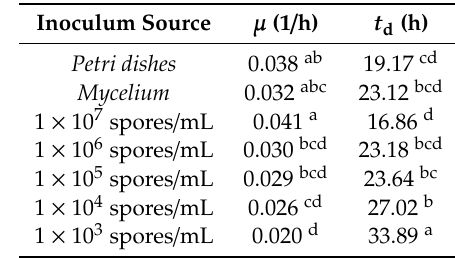
Table 2. Kinetic parameters for Streptomyces clavuligerus cultivation according to di ff erent inoculum